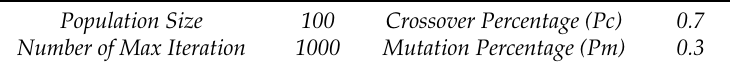
Table 8. Genetic Algorithm